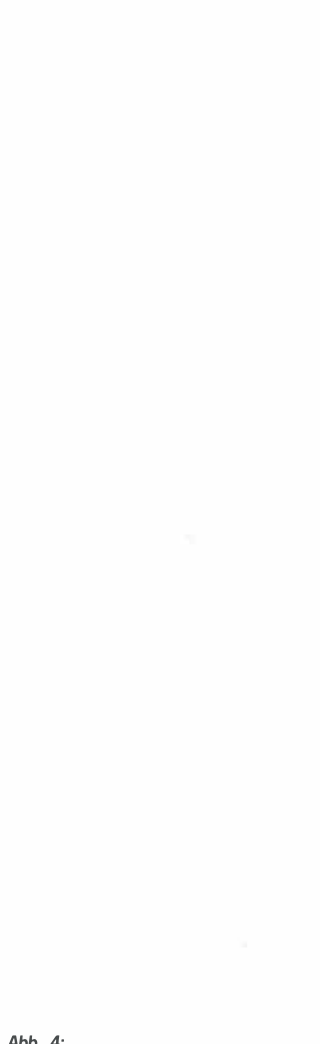
Fig. 4: Squared bond forces; difference between the mean value of entangled sections of the polymer chain and the system as a